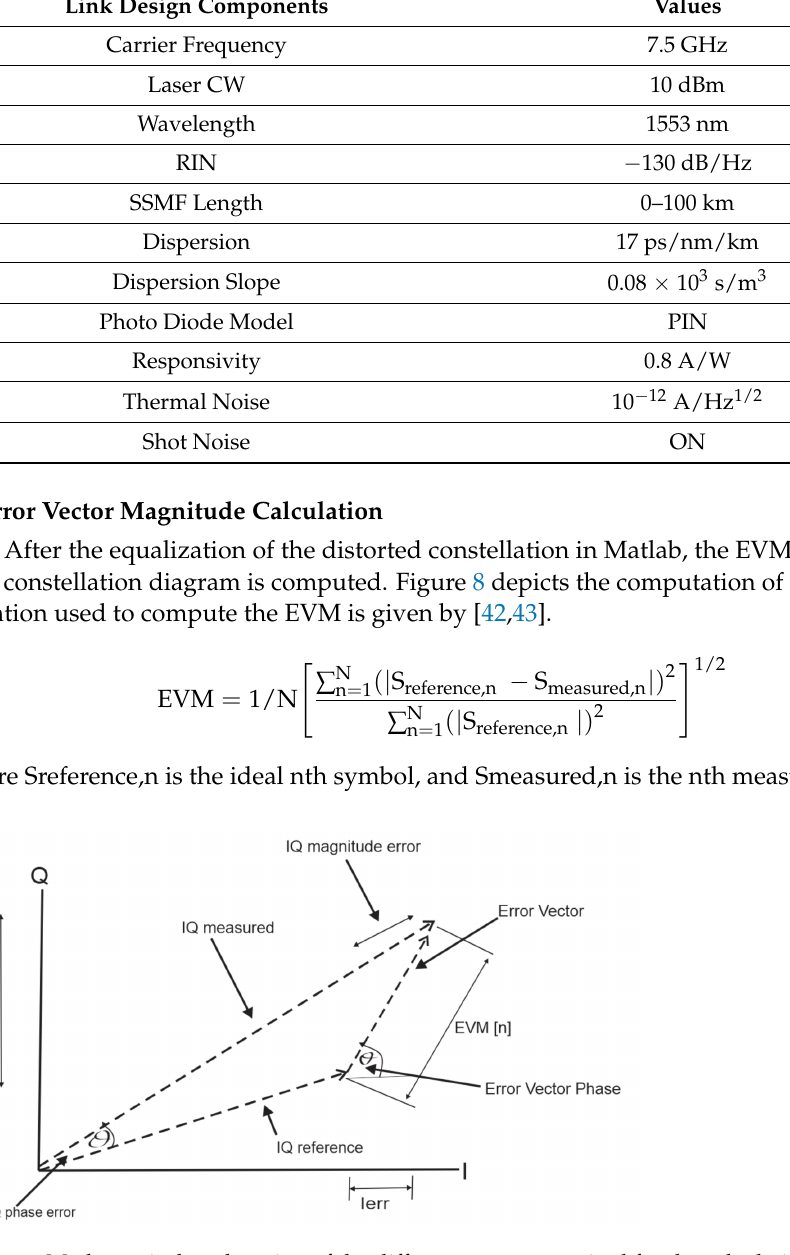
Figure 8. Mathematical explanation of the different vectors required for the calculation of the Error Vector Magnitude